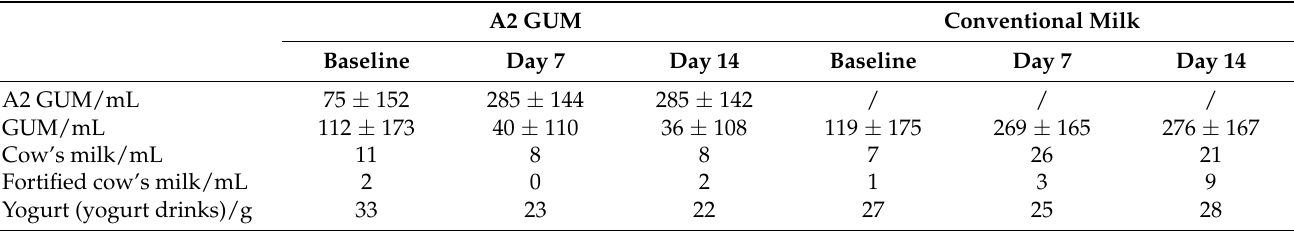
Table A1. Milk intake in the past 24 h among FAS participants.